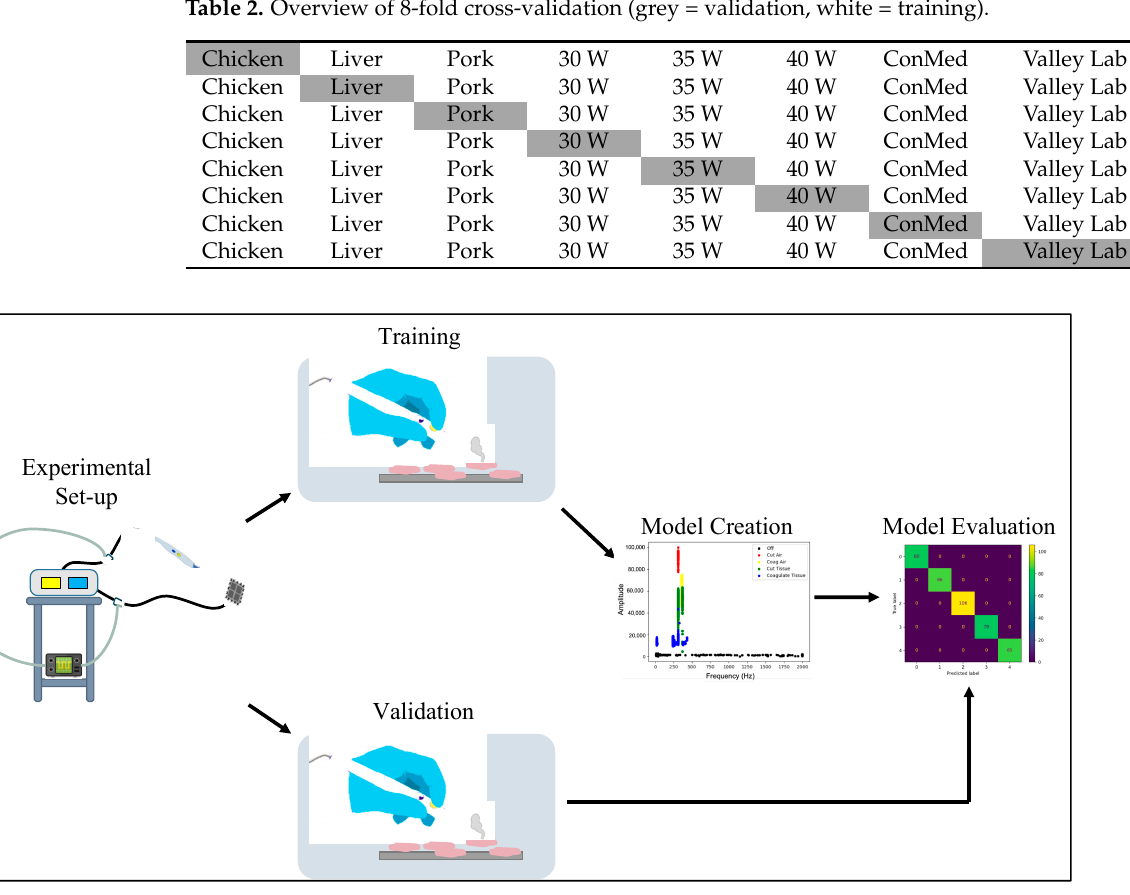
Figure 3. Overall workflow: experimental set-up, data acquisition, model training, validation. Mass spectrometry of tissue smoke is used to determine the classification of the tissue subjected to elec- trocautery.